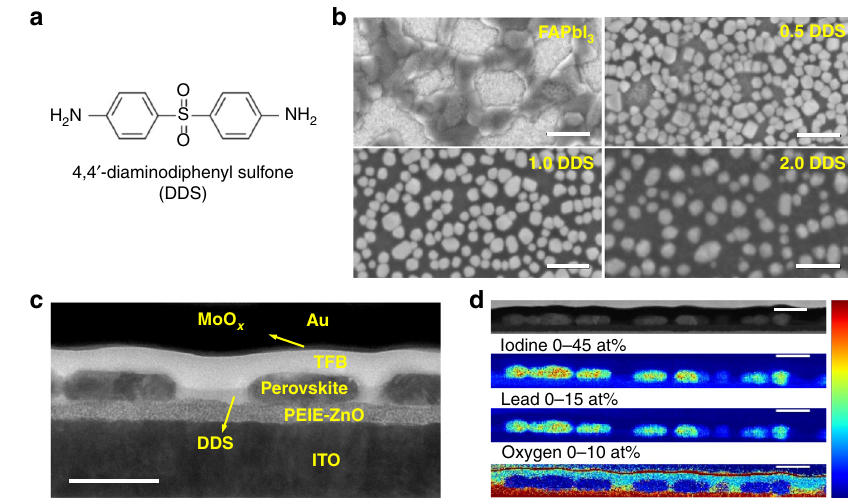
Fig. 1 Morphology of PMC thin fi lms. a Molecular structure of DDS. b Top-view SEM images of perovskite fi lms. The scale bars are 500 nm. c Cross- sectional bright- fi eld TEM image, and d cross-sectional HAADF-STEM image and associated EDS maps of the 1.0 DDS fi lm-based LED. The scale bars are 200 nm.